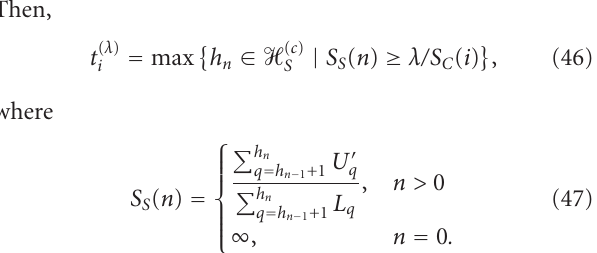
Figure 8: Case 2 of the COP allocation algorithm. At step t , the last COP is divided into two, the first of which, (cid:5) C t , satisfies NS